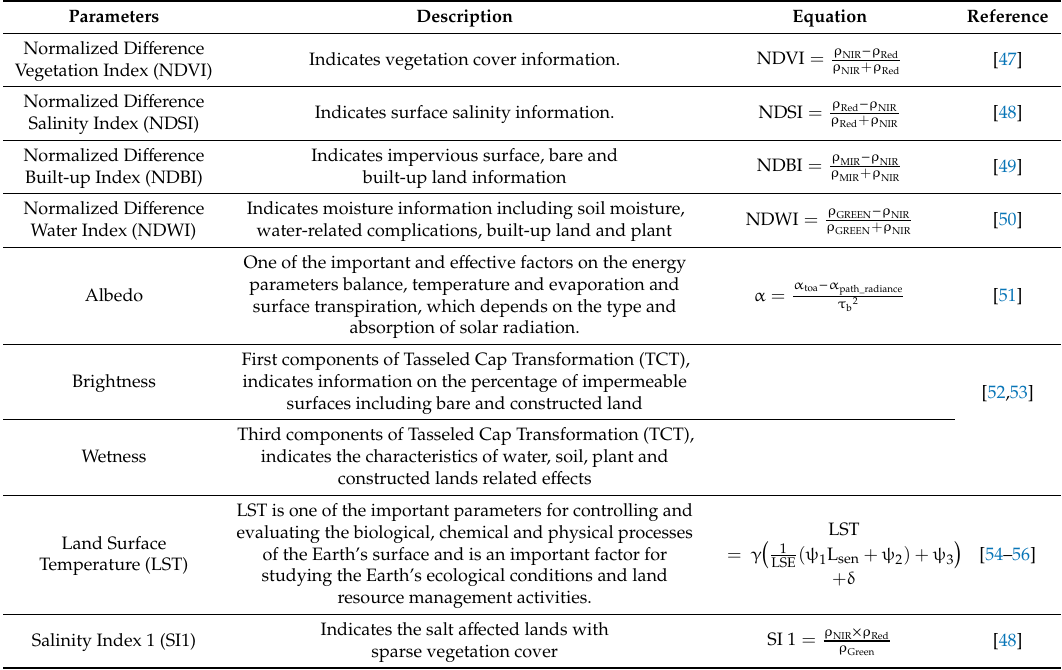
Table 2. Surface biophysical characteristics used in this